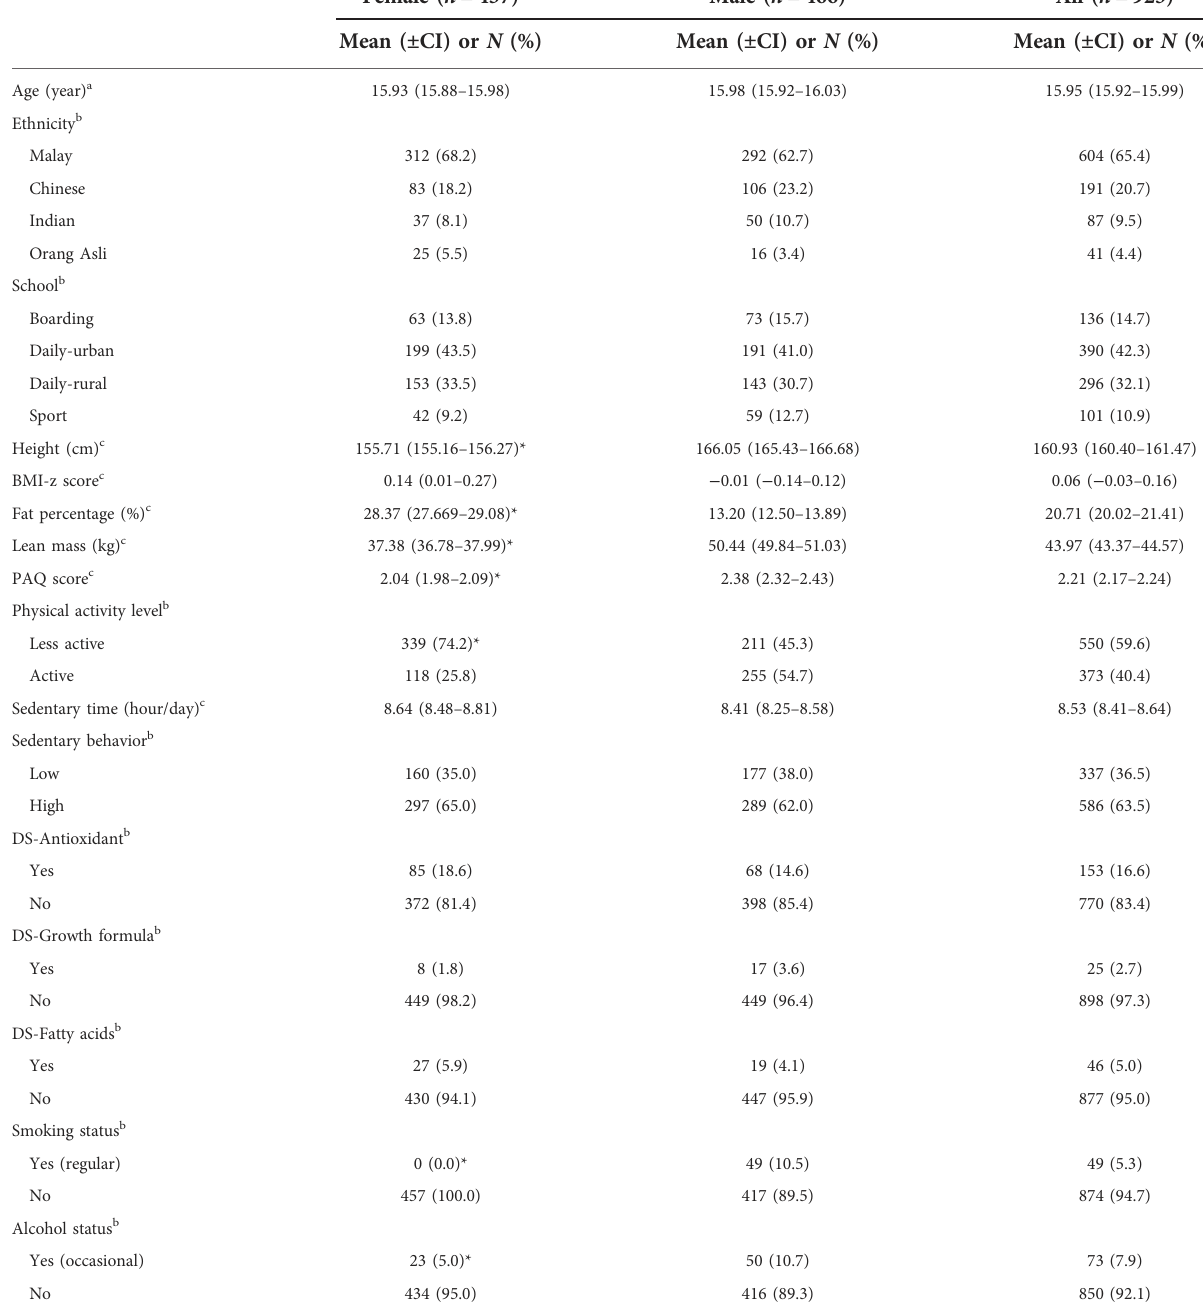
TABLE 1 Sample population characteristics ( n